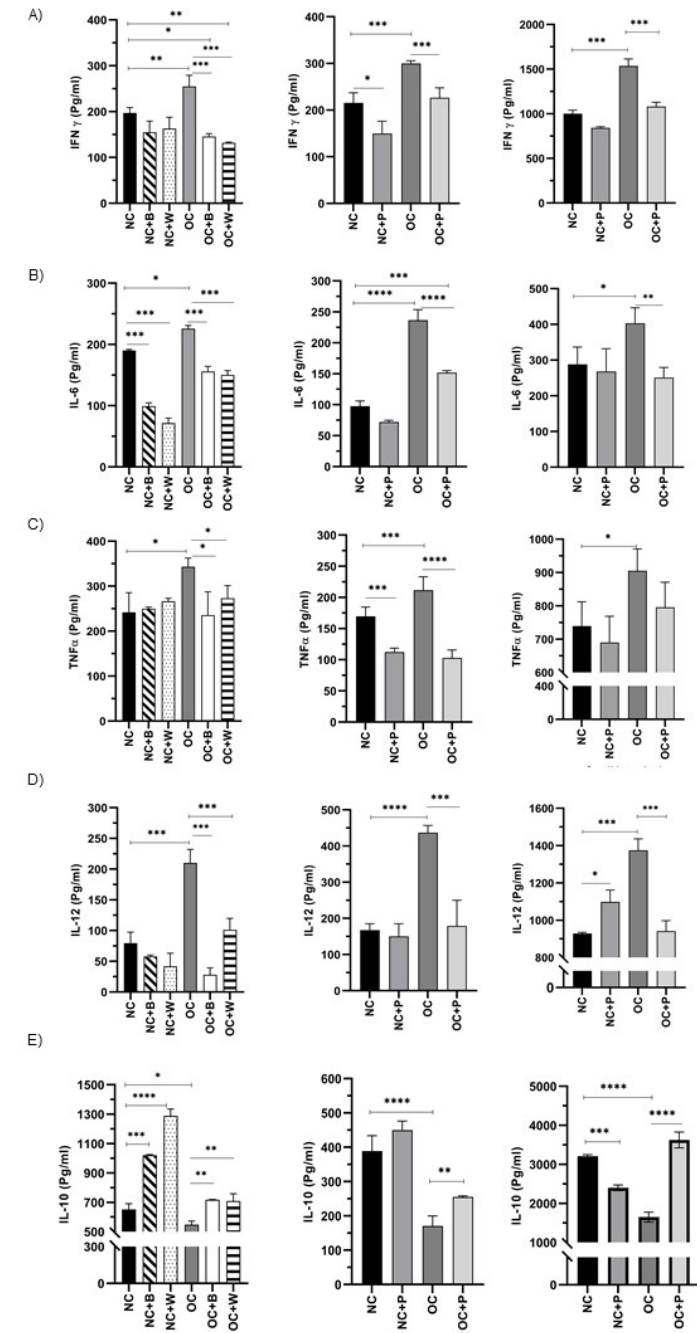
Figure 5. Cytokine production in the obesity mouse model. The levels of different cytokines: ( A ) IFN- γ , ( B ) IL-6, ( C ) TNF- α , ( D ) IL-12 and ( E ) € IL-10 were determined in the thymus, serum, and small intestinal fluid from the animals: NC (normal control); (NC+P) receiving a balanced diet and probiotic bacterium in the drinking water; (OC) fed water and a high-fat diet; (OC+P) fed a high-fat diet and a probiotic suspension with Lc431. In vitro cultures of thymocytes were stimulated with the probiotic bacterium (B) or its probiotic cell wall (W). Data were shown as mean ± SD of 3 independent experiments with 3 mice per group. One-way ANOVA with Tukey’s correction for multiple comparisons. * p < 0.05; ** p < 0.01; *** p < 0.001; **** p <